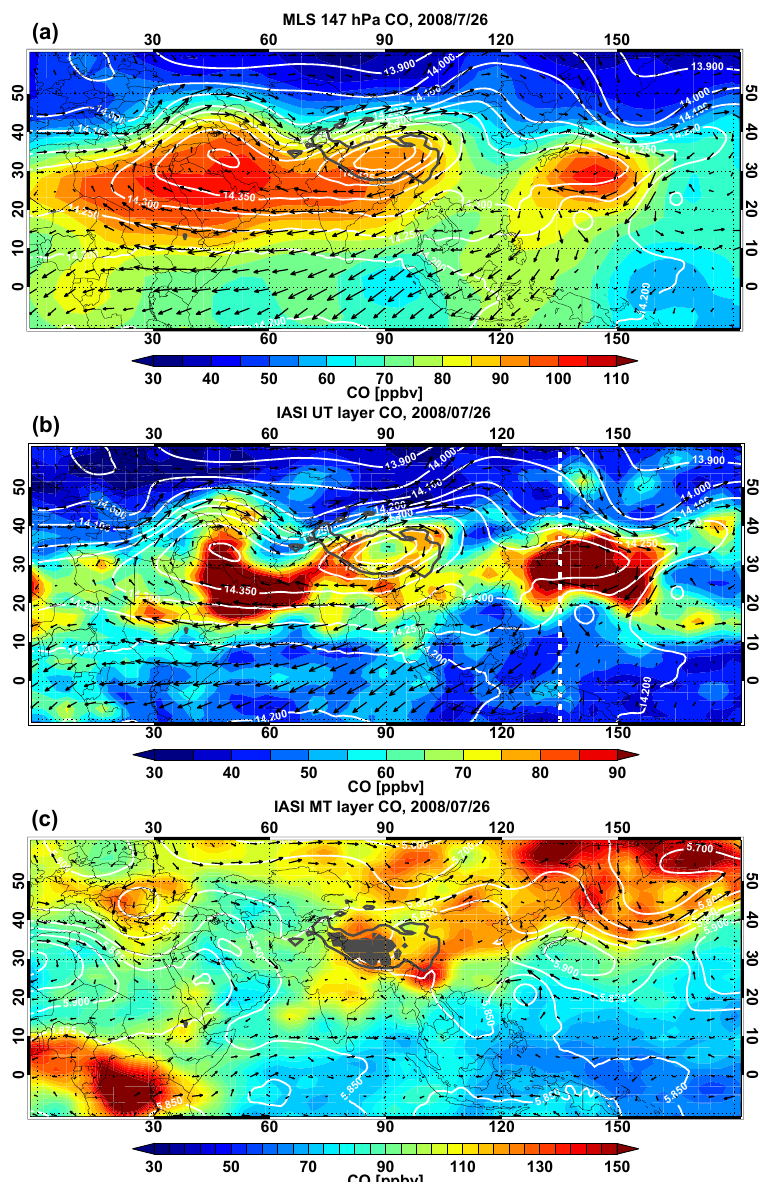
Figure 7. (a) MLS 147hPaCO, (b) IASI UT layer CO, and (c) IASI middle troposphere (MT) layer CO for a selected day (26 July 2008). Dynamical fields of GPH (white contours) and horizontal winds (black arrows) for the corresponding levels (150hPa for a and b , 500hPa for c ) are superimposed. Elevated terrain is indicated by gray shadings for the 500hPa map in (c) . The location of the Tibetan Plateau (using 3km elevation) is also shown in the maps (thick gray line). The dashed white line in (b) marks the location of the cross section shown in Fig.